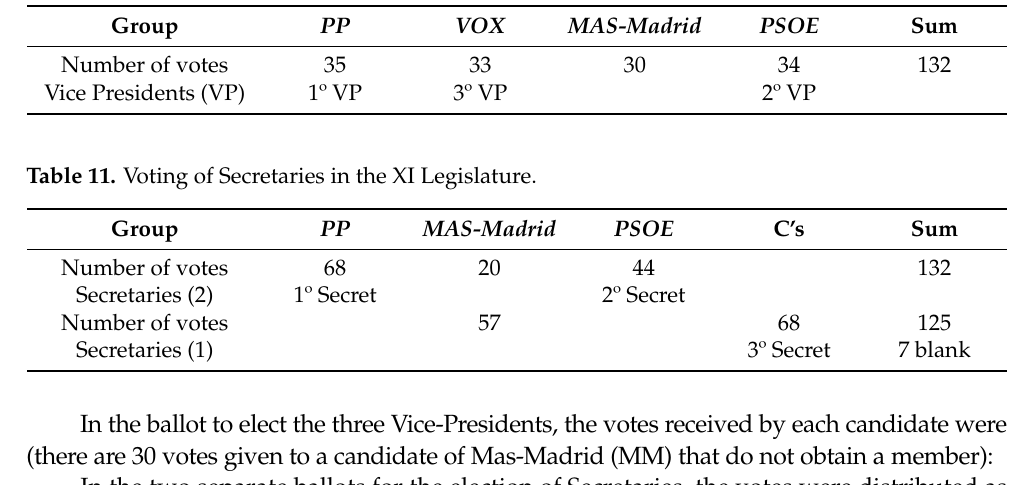
Table 10. Voting of Vice-Presidents in the XI Legislature.